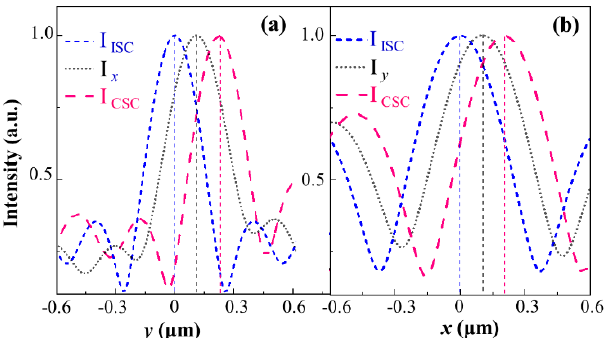
Figure 4. Normalized intensity profile curves of the characteristic bright spots extracted from Figures 3(a2,b2,c2) along the green vertical dash lines ( a ) and from Figures 3(a2,b2,d2) along the black horizontal dash lines ( b ). The distributions in all curves are normalized to their maximum values. Different colors refer to different components.